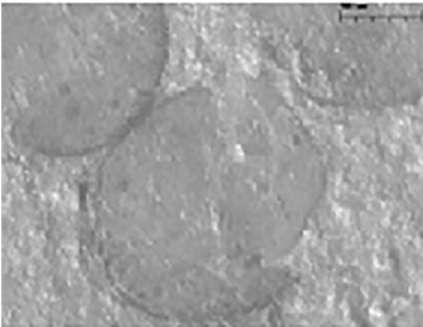
FIGURE 1 - SEM Image of Cross-sections of tablet using PEG 400 as plasticizer.